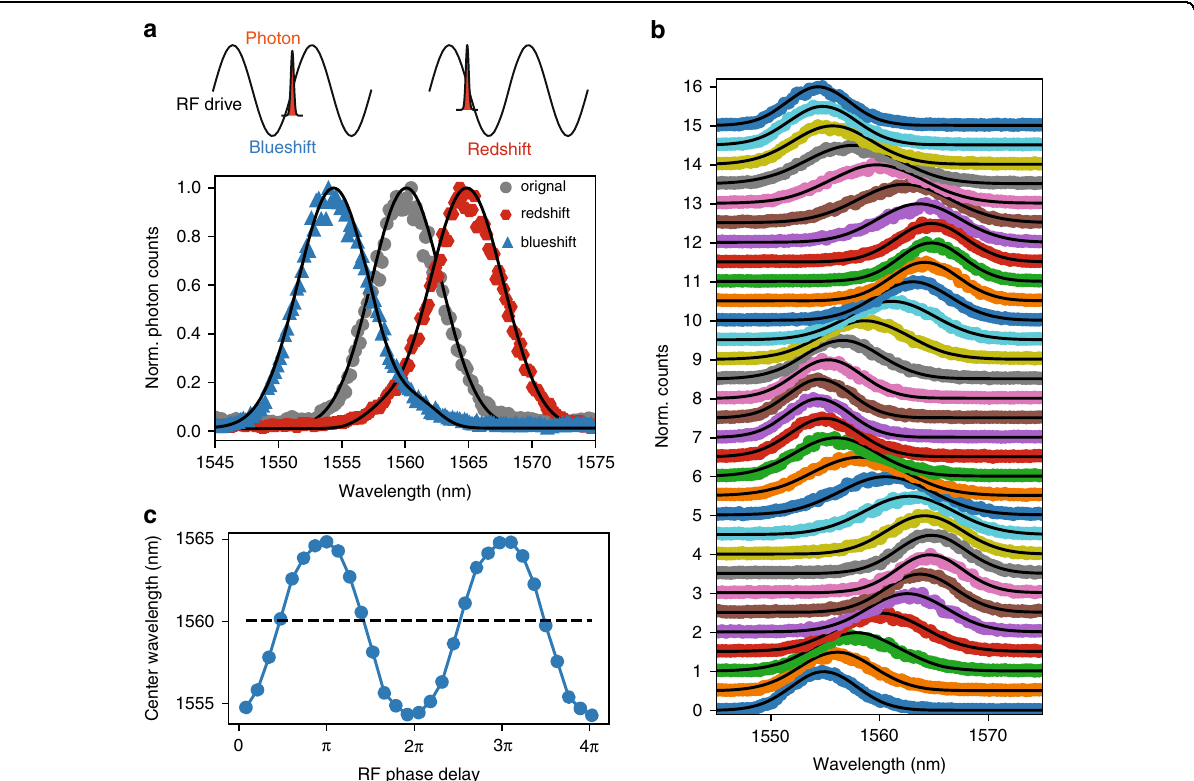
Fig. 3 Single-photon spectral shearing. a Measured single-photon spectra when the photon was locked at the rising and falling slopes of the sinusoidal RF drive. b Waterfall plot of the measured single-photon spectra with increasing RF phase delay (~0.13 π step), showing that the center frequency can be tuned continuously. The spectra were normalized to their maximum value to account for coupling drift during measurement and displaced vertically for ease of visualization. Due to timing jitter between the RF drive and optical pulse, we observed a spectral broadening of photon bandwidth, especially near zero-shift positions. Black solid lines are Gaussian fi ttings. c Extracted frequency shift as a function of RF phase delay, showing maximum shift of ±5.2 nm (± 641 GHz). The input photon was at 1560 nm with a FWHM bandwidth of 6.5 nm. The modulator was driven at 27.5 GHz with an amplitude of 8.1 V π ( V π ≈ 2.5